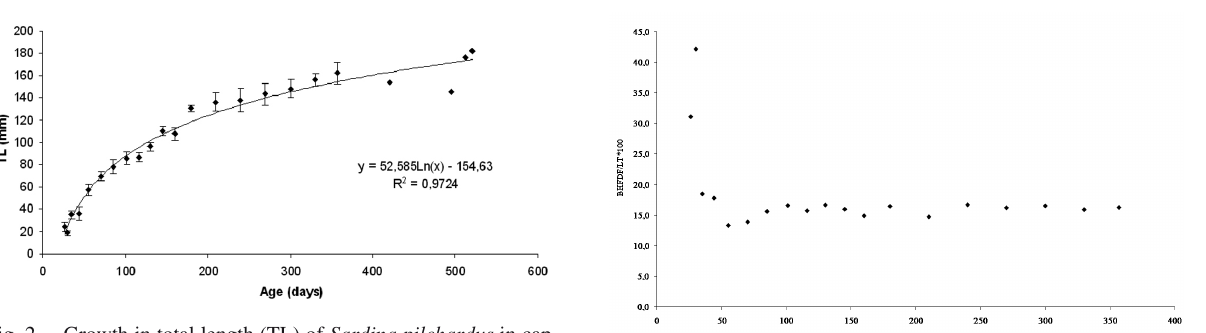
Fig. 2. – Growth in total length (TL) of Sardina pilchardus in cap- tivity up to 18 month of life.